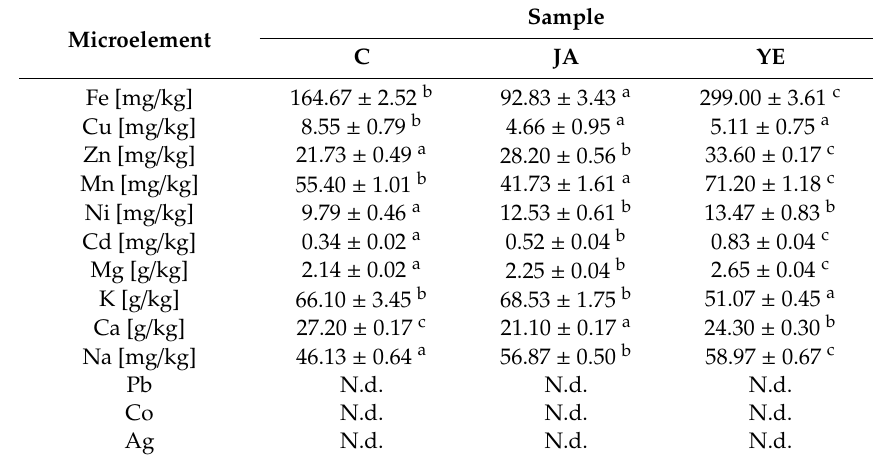
Table 4. Content of microelements in the control and elicited